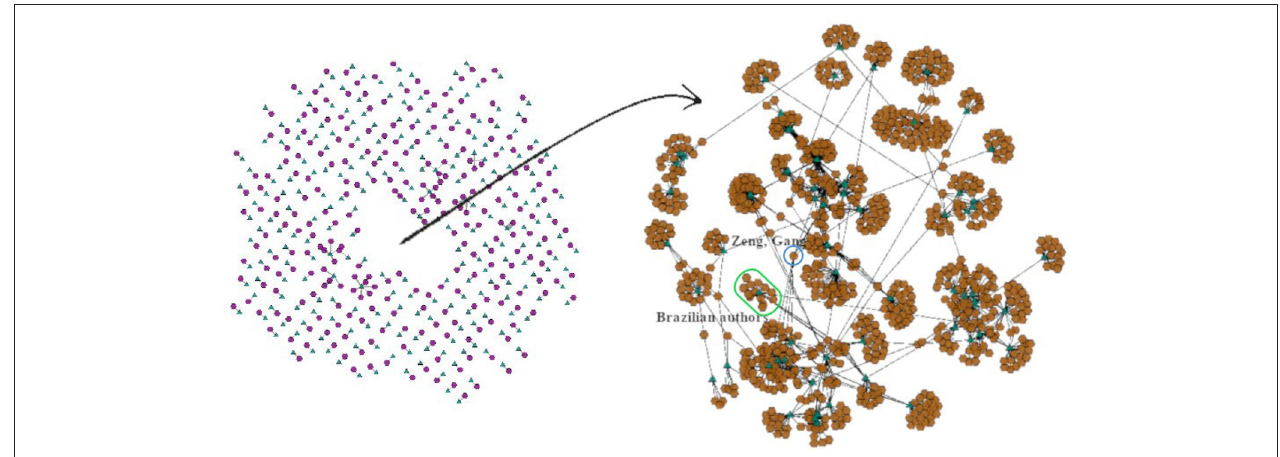
FIGURE 12 | Further exploratory investigation of a selected group, departing from the coarsest network. The bigger central group in Figure 10B has been isolated and locally expanded back to level 0, for observation of its detailed